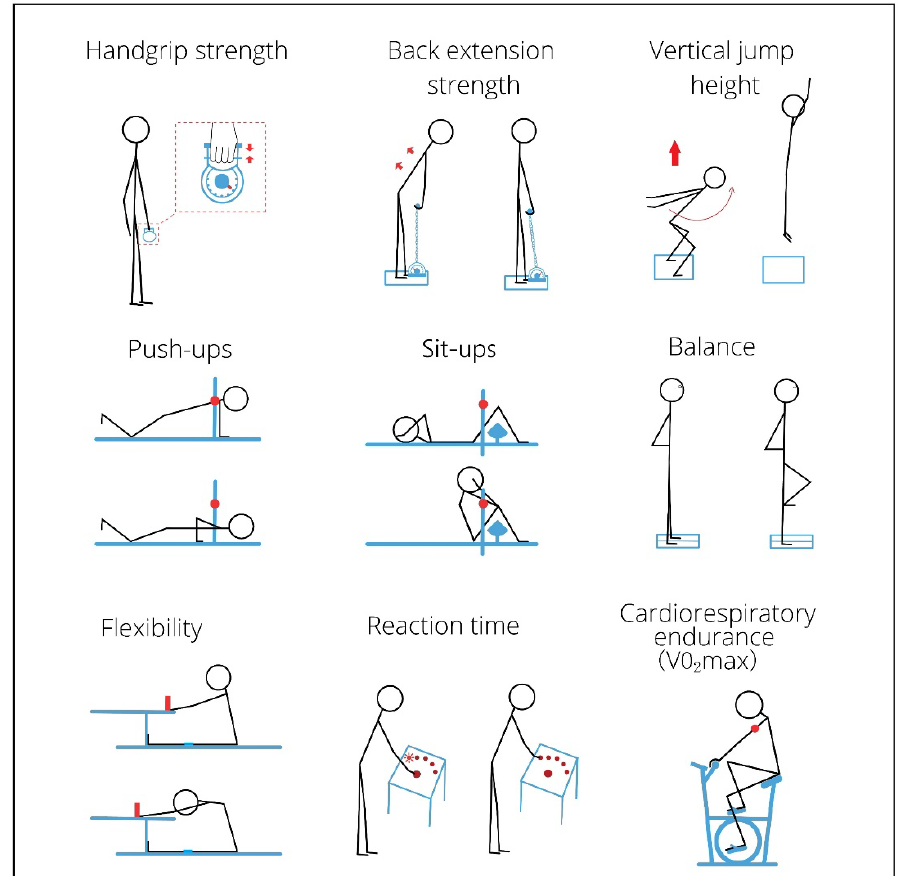
Figure 2. An illustration of the tests of physical fitness .